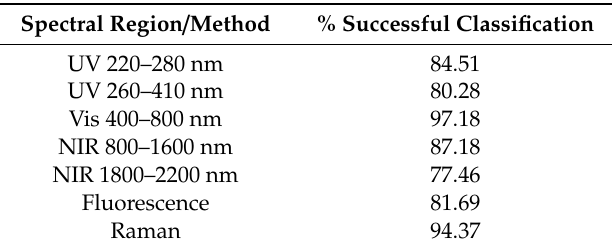
Table 1. Rate of successful classification (%) of the olive oil samples by partial least squares discriminant analysis (PLS-DA) for all spectral regions/methods.